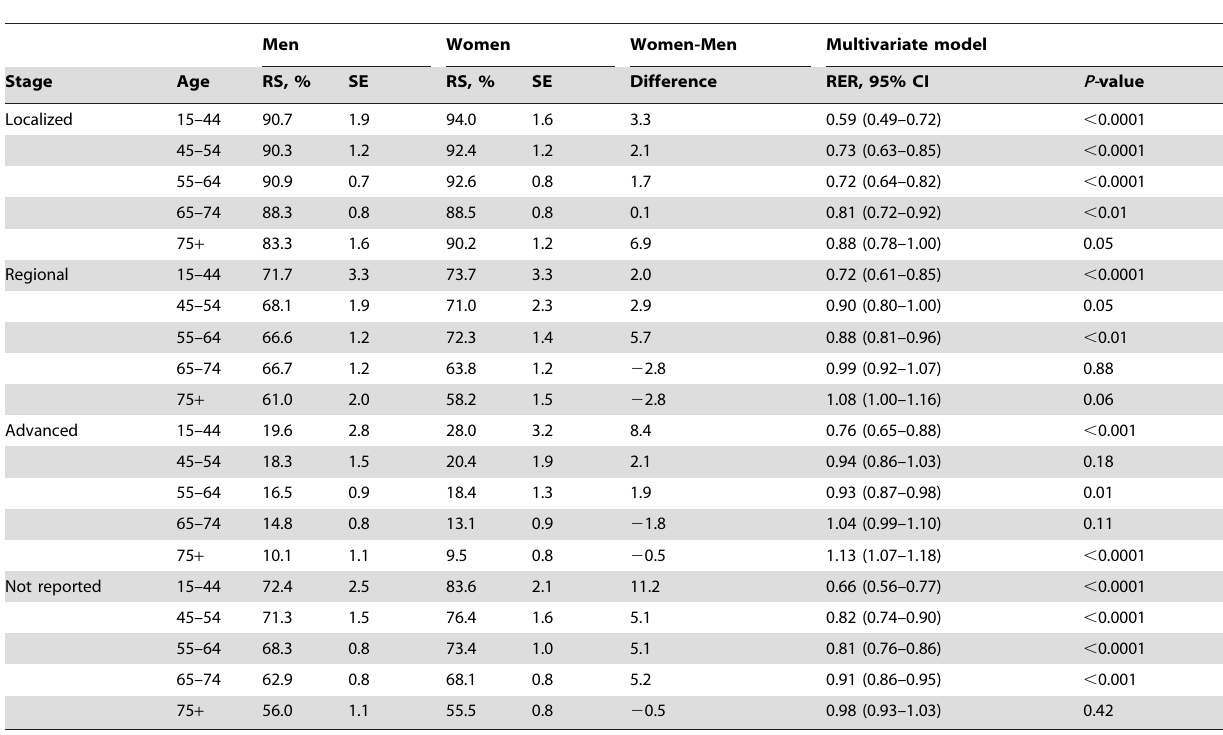
Table 4. Sex differences in 5-year relative survival of colorectal patients for subgroups by stage and age.